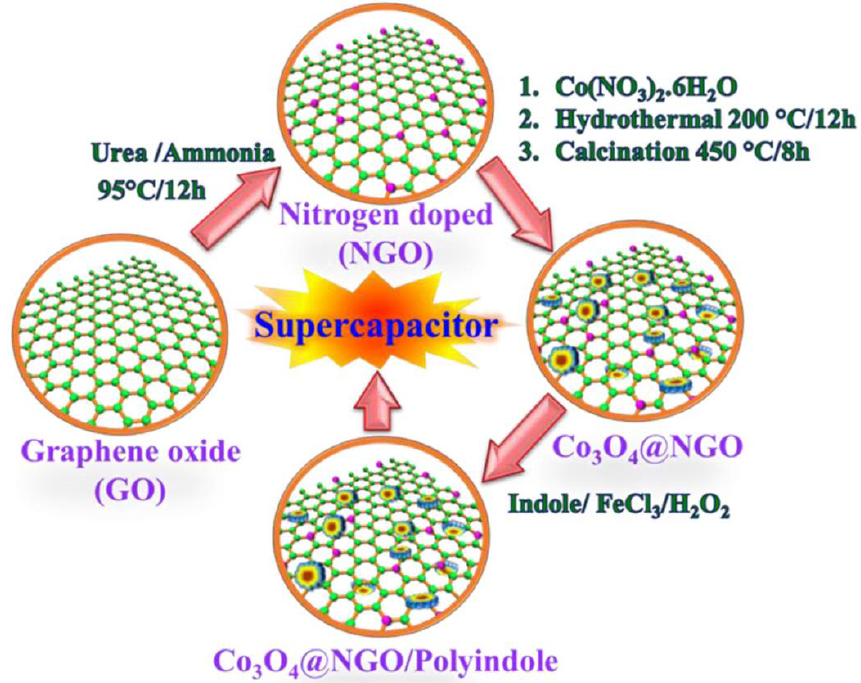
Figure 3. Schematic representation for the synthesis of Co 3 O 4 @NGO and Co 3 O 4 @NGO/Pind composites (Reprinted from ref. [90]).